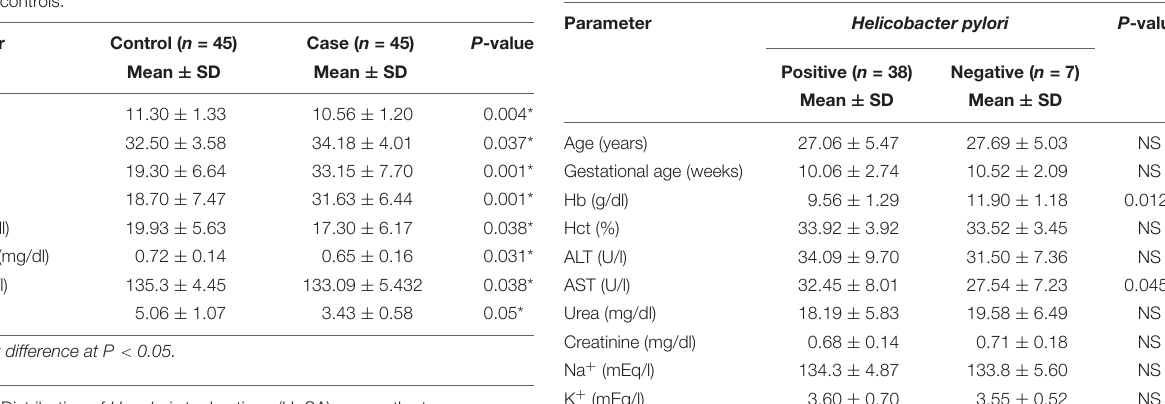
TABLE 4 | Relationship of H. pylori to different parameters among